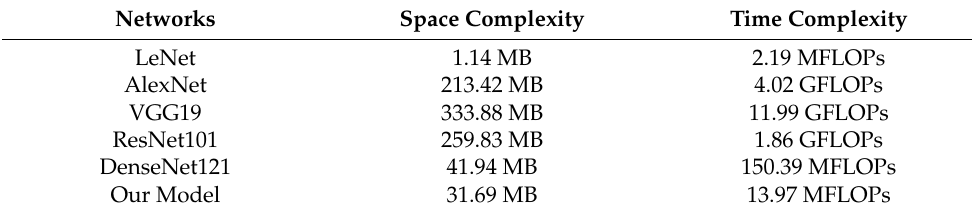
Table 1. Comparison of space complexity and time complexity of CNN